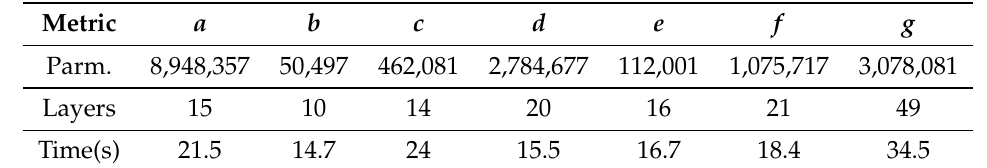
Table 5. Comparing different networks’ parameters: number of network parameters (Parm.) and layers (Layers), and testing processing time (time).